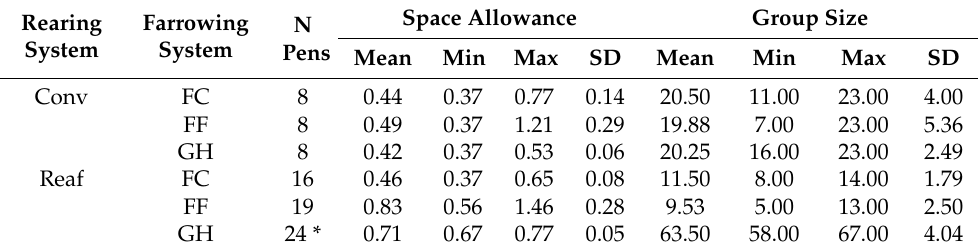
Table 1. Mean, minimum, maximum and standard deviation (SD) of space allowance per pig in square meters [m 2 ] and of group size per rearing and farrowing system during rearing period. Rearing Farrowing System System